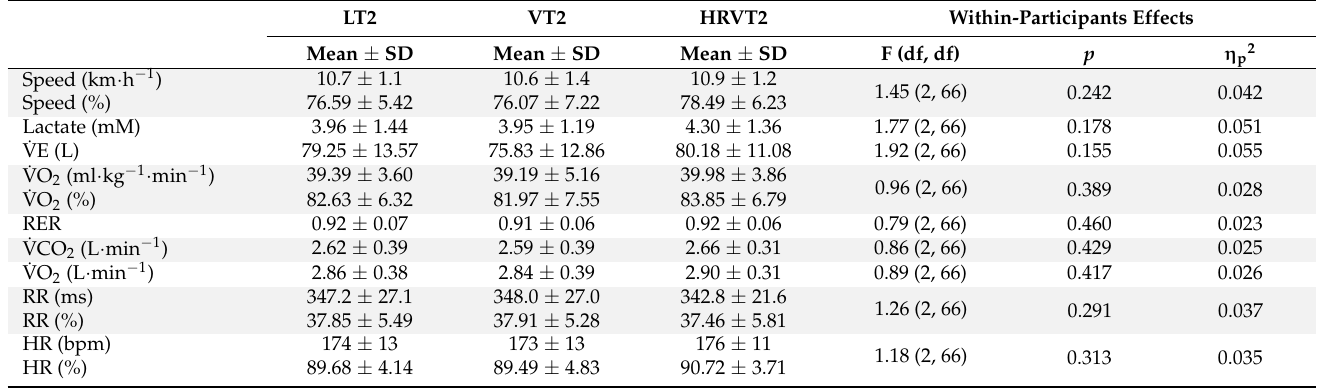
Lactate threshold 1 (LT1), ventilatory threshold 1 (VT1), and heart rate variability threshold 1 (HRVT1). Ventilation ( ˙VE), relative oxygen consumption ( ˙VO 2 ), respiratory exchange ratio (RER), carbon dioxide consumption ( ˙VCO 2 ), R-R interval (RR), heart rate (HR), variable of heart rate variability (RMSSD), F statistics and degrees of freedom (F(df, df)), partial eta-squared ( η p2 ). * ( p < 0.05) different from LT1; † ( p < 0.05) different from VT1; § ( p < 0.05) ANOVA effect. Percentage values relative to the maximum (for RR it is relative to baseline). Table 3. Comparison between the means of the methods for identifying thresholds 2 in